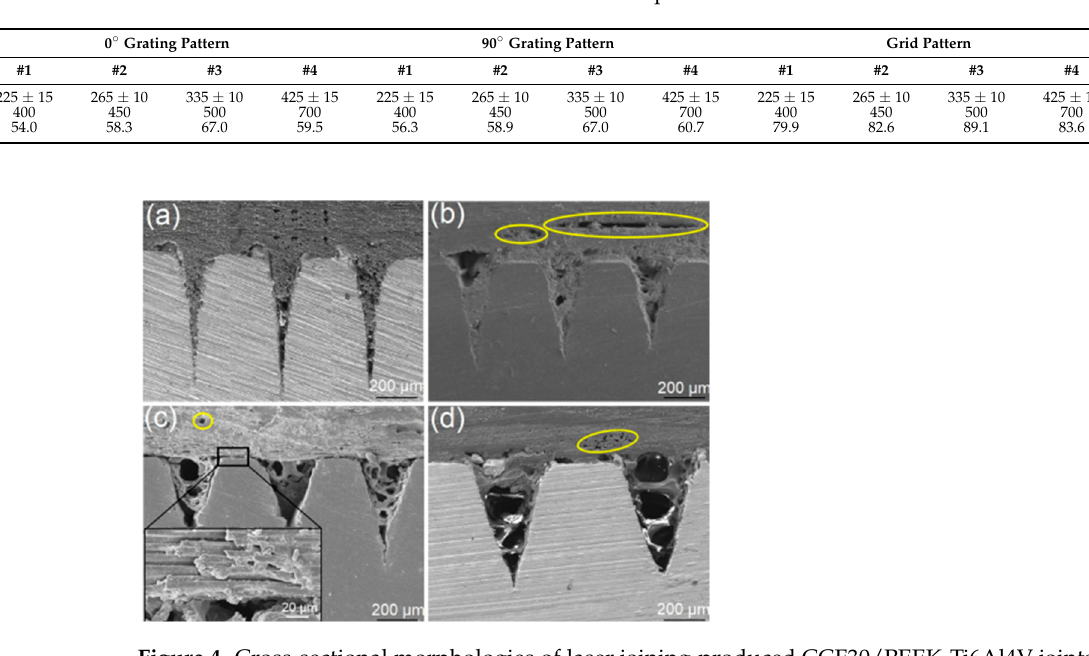
Table 3. Structural characteristics of laser machined patterns.